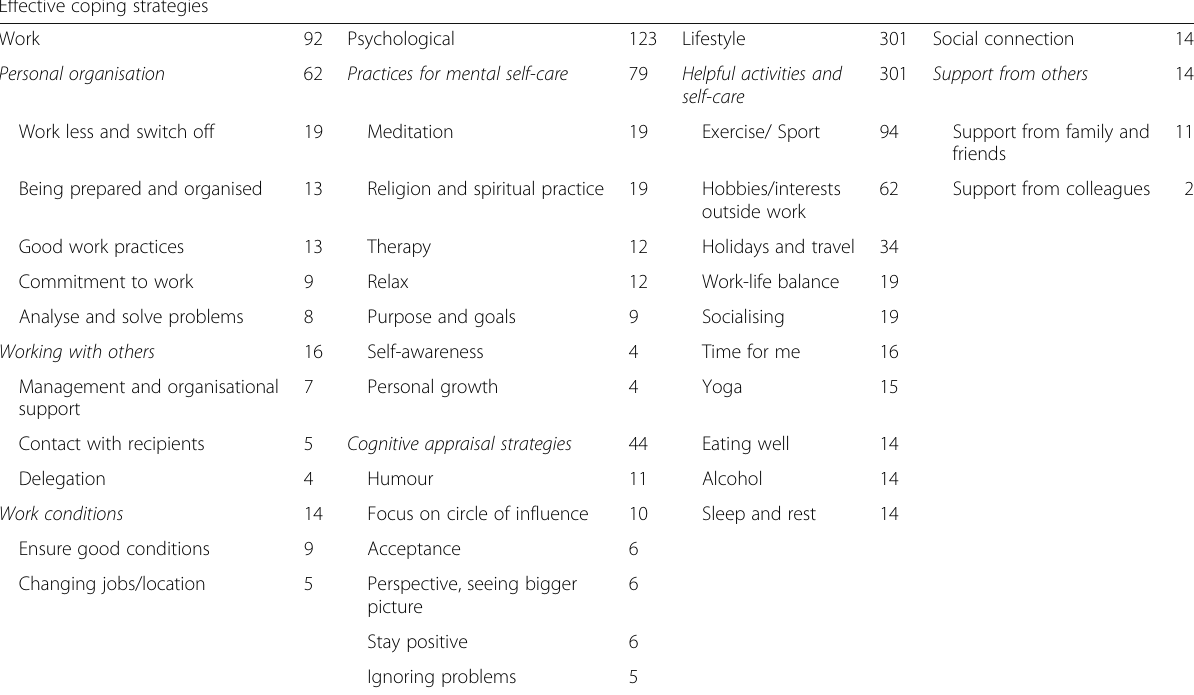
Table 2 Effective coping strategies code frequency grouped by four overarching themes and seven sub-themes Effective coping